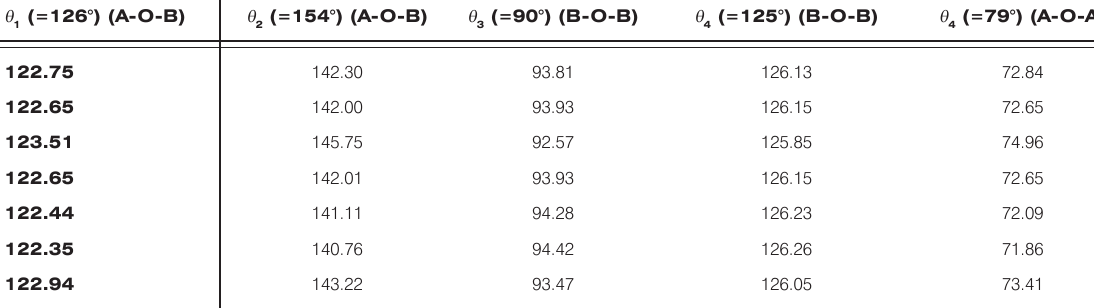
Table 5. Relative bond angle ( θ ) for magnetic interactions (A-O-A, A-O-B, B-O-B). θ (=126°) 1